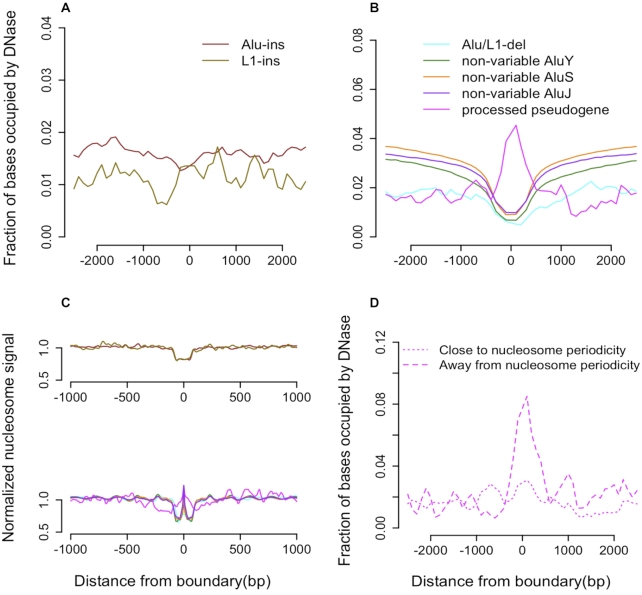
(A) No enrichment/depletion of DNase sites is observed around retrotransposons discovered as insertions. (B) Depletion of DNase sites is observed around breakpoints of deleted retrotransposons as well as non-variable Alu elements, suggesting that the effect is due to compromised read mapping around repeats. Insertion sites of processed pseudogenes are enriched with DNase sites. (C) Retrotransposon insertion sites are depleted with nucleosome signal. TEI, non-variable Alu, and processed pseudogenes also support depletion of the nucleosome signal around breakpoint. The peak at the center of the X-axis (lower panel) represents the normalized mean nucleosome signal within element boundaries. (D) DNase signal is enriched only around pseudogenes where length is away from nucleosome periodicity (∼150 bp).